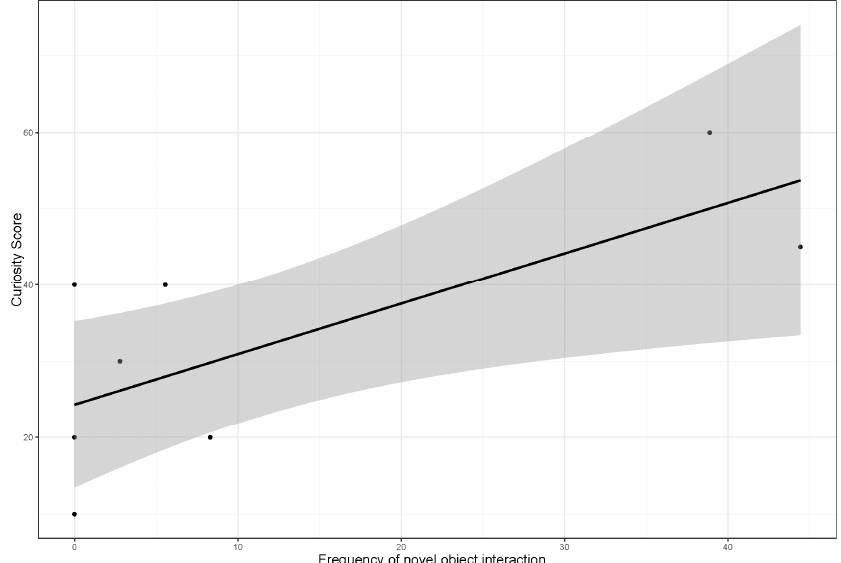
Figure 8. Linear regression model of influence of curiosity on frequency of novel object interaction with the grey area as 95% confidence level. The dots indicate the respective data points. Data points outside the grey confidence level are outliers.